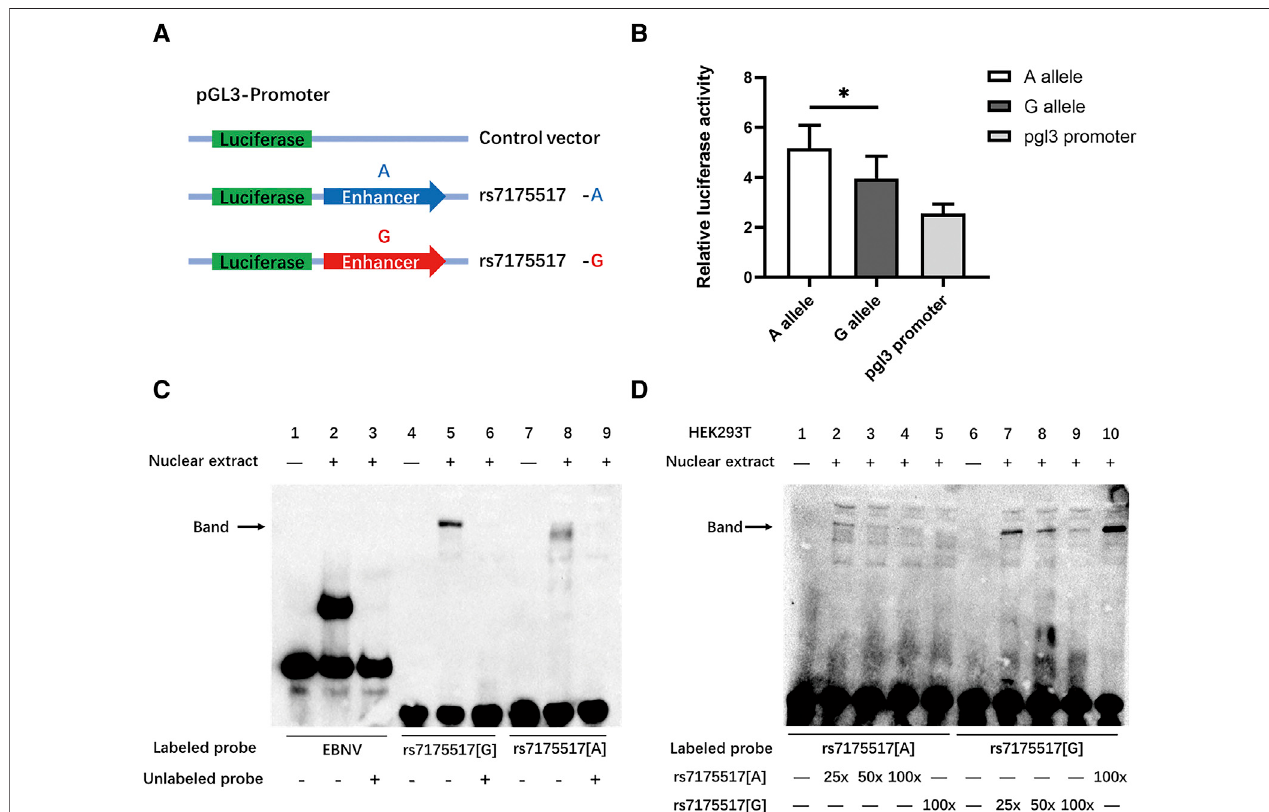
FIGURE 3 | G allele of rs7175517 reduced the expression of MEK5 via binding with more inhibitor. (A) , Luciferase reporter assay for the region encompassing rs7175517. Each allele-speci fi c construct contained 500 bp upstream and 500 bp downstream of the putative mutated site. All constructs were introduced into the pGL3-promoter luciferase reporter vectors. (B) , All constructs as indicated (100 ng per well into 24-well plates) were transiently transfected into human embryo kidney 293T (HEK293T) cells in triplicate for 48 h. (C) , EMSAwithbiotin-labeled oligonucleotides contained the rs7175517 G allele or rs7175517A allele, and nuclei were extracted from HEK293T cells. Lanes 1, 4 and 7 show the mobility of the corresponding labeled oligonucleotides without nuclear extracts; lanes 2, 5 and 8 show the mobility of the corresponding labeled oligonucleotides with nuclear extracts in the absence of competitor; lanes 3, 6 and 9 show the mobility of the labeled oligonucleotides with nuclear extracts in the presence of unlabeled competitor. For example, more unlabeled rs7175517 oligonucleotides were added into the premixture of biotin-labeled rs7175517 to compete for the interaction with nuclear extracts. The arrow indicates a DNA-protein complex for rs7175517. (D) , EMSA competition assays. Lanes 1-5 indicate the competition assay for the rs7175517 A allele, and all lanes added 80 fmol biotin-labeled oligonucleotides containing the rs7175517 A allele. Lane 1 refers to those without nuclear extracts; Lanes 2, 3 and 4 refer to those with nuclear extracts and are in the presence of 25×, 50× and 100× unlabeled oligonucleotides containing the rs7175517 A allele; lane 5 refers to those with nuclear extracts and is in the presence of 100× unlabeled oligonucleotides containing the rs7175517 G allele. With the increasing amount of unlabeled oligonucleotides, the band should slowly become shallow, particularly for adding stronger interaction alleles. Similar results were presented in lanes 6 – 10. For lane 10, since rs7175517 G allele had stronger interaction with nuclear extracts, even 100× rs7175517 A allele was added, no fade was observed in the band. All the experiments were repeated three times, and only one experimental result was represented for each kind ofexperiment. Forthe dual luciferase assay, Student ’ s t test wasadopted totest the mean differences between different conditions, and a p value < 0.05was considered statistically signi fi cant.